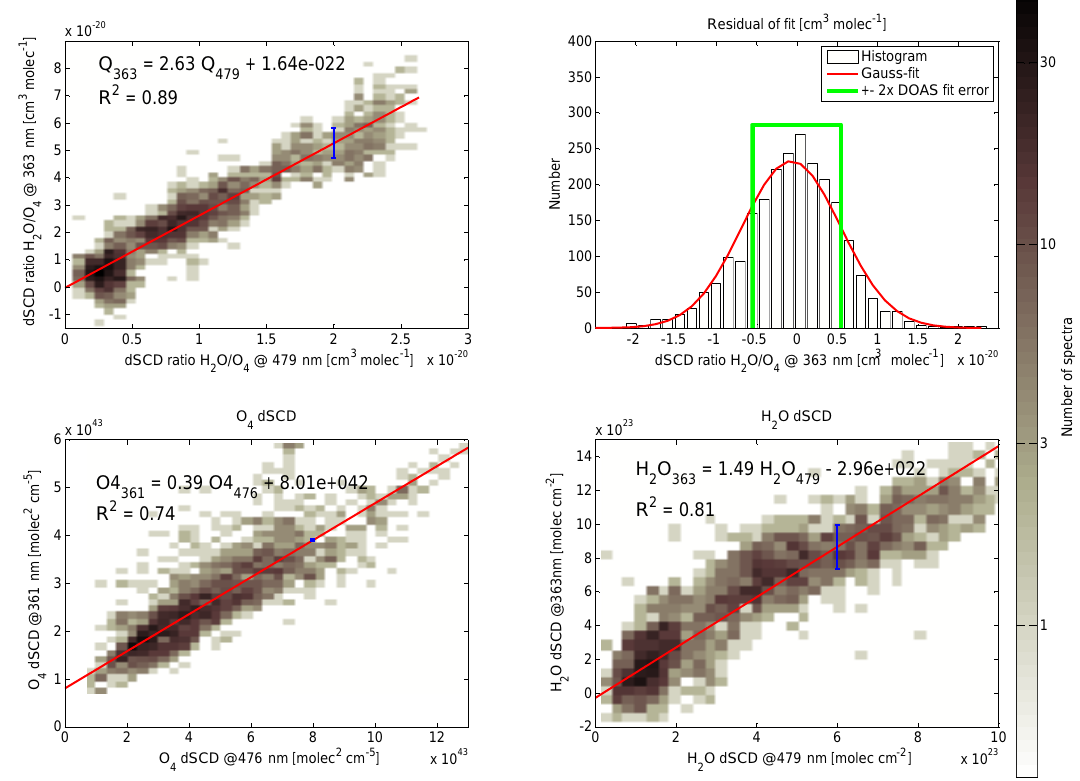
Figure 6. Top left panel: ratio of water vapour dSCD and O 4 dSCD at 363 and 479nm for a telescope elevation angle of 3 and 5 ◦ during ANT XXVIII/1-2, using the O 4 cross section by Thalman and Volkamer (2013). Error bars represent typical measurement errors and are calculated from fit errors of both absorbers. Error bars for the ratios at 479nm are omitted. They are more than 1 order of magnitude smaller than those at 363nm. A ratio of 10 − 20 cm 3 molec − 1 corresponds to an absolute water vapour-mixing ratio of 0.01 at ground level or a vertical column density of 5 × 10 22 moleccm − 2 or 15kgH 2 Om − 2 , assuming a scale height of 2km. Top right panel: the residual of the linear fit shows a Gaussian distribution and agrees with respect to its width of σ = 6 . 12 × 10 − 21 cm 3 molec − 1 with the mean measurement error (2 times DOAS fit error, 2 . 75 ± 0 . 92 × 10 − 21 cm 3 molec − 1 ) obtained from the DOAS fit. The contribution of the statistical error of the linear fit is negligible. The individual correlations of H 2 O and O 4 dSCDs are shown in the lower panels, which show individually smaller correlation coefficients than their respective ratios at 363 and 479nm. Table 3. Results from Fig. 6 to determine the relative magnitude of the water vapour absorption at 363nm compared to 477nm, using the HITEMP cross section for different retrieval settings using different O 4 cross sections. Values in brackets denote the error of the last digits of the respective value calculated from the error-weighted linear regression. For LP-DOAS measurements (see Sect. 4.1), the correlation was done for slant column densities (SCDs) instead of H 2 O / O 4 dSCD ratios because the light path was constant. The offset (LP-DOAS) was, however, normalised by the mean O 4 dSCD at 360nm in order to have comparable values. The systematic error of the slope was determined by using the typical relative measurement error of water vapour for measurements at a dSCD of 3 × 10 23 moleccm − 2 determined in the respective blue wavelength